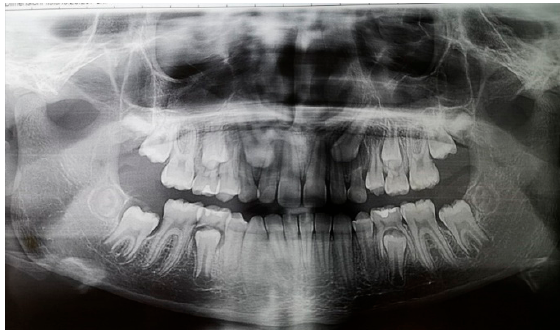
Figure 1. Panoramic radiograph detecting.